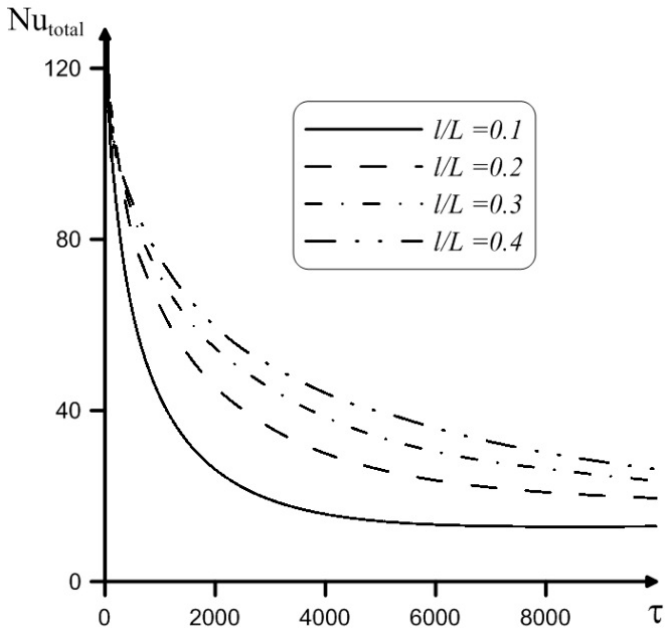
Figure 5. Dependence of the average total Nu at the heater wall vs. heat source height and non-dimensional time at (cid:101) ε h = 0.5.